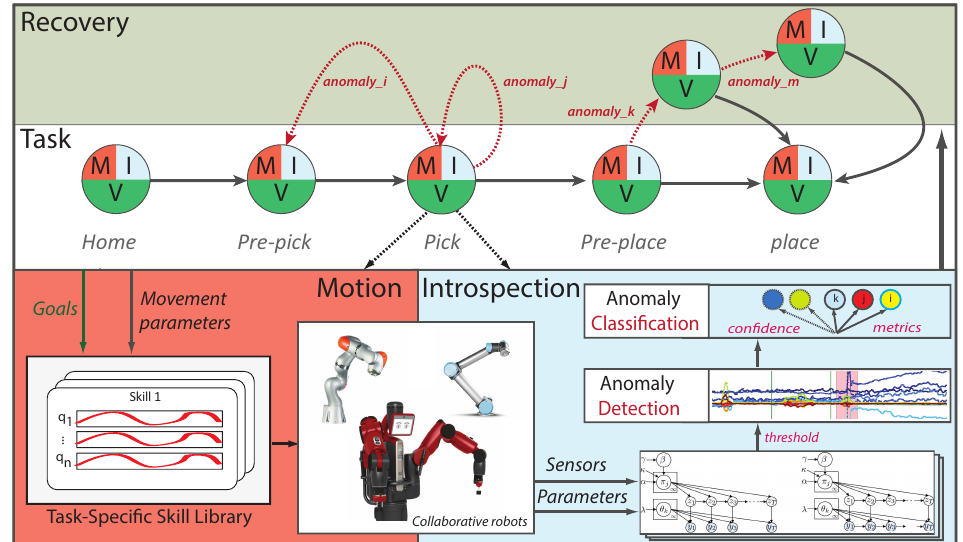
Figure 1. Manipulation tasks are controlled through a graph-based scheme consisting of nodes and edges. Each node contains three types of modules: (i) motion; (ii) visualization; (iii) and introspection; all of which run in parallel. Motion modules use pose goals provided by the visualization module as well as node-specific skill parameters to generate desirable skills. Introspection modules use node-specific model, parameter, and hyper-parameter settings to continually look for anomalies. If detected, the introspection modules further classify them. A recovery critic then issues a policy for re-enactment or